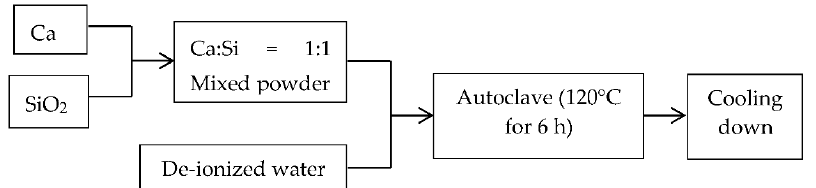
Figure 1. Scheme of the synthetic procedure of highly crystalized nano calcium silicate hydrate (C-S-H) particles.